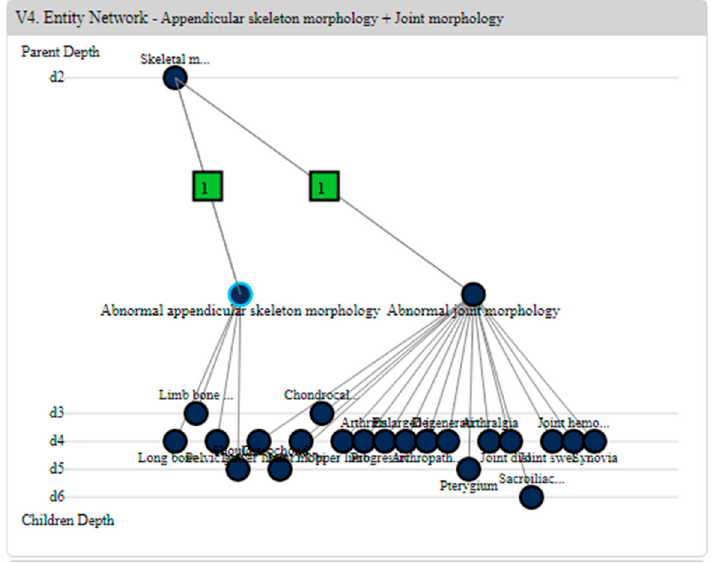
Figure 31. The initial state of the Entity Network Panel subview when two ontology entities are chosen as the initial positions. In this case, “Abnormal Appendicular Skeleton Morphology” and “Abnormal Joint Morphology” have been selected.